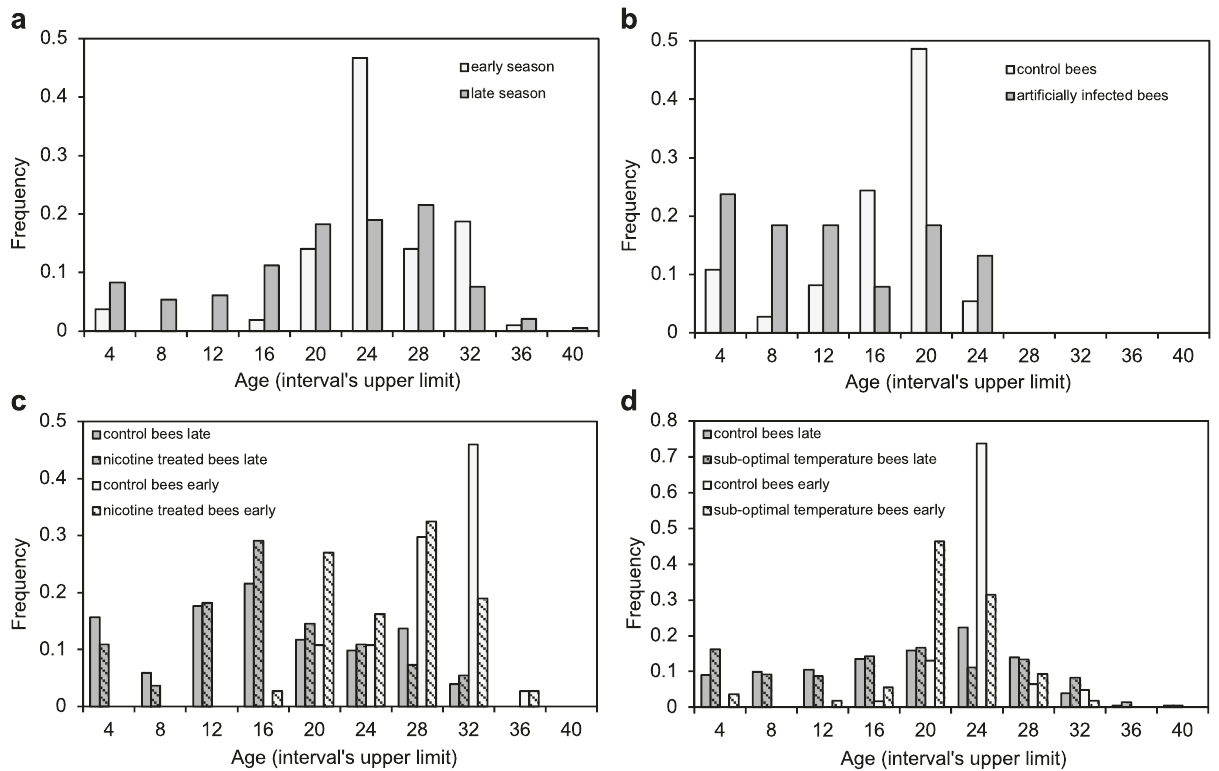
virus is widespread (gray bars with diagonal pattern); the corresponding distribu- tionofhoneybeessampledearlyorlateintheseasonandnotexposedtothetoxic compoundasacontrol(whiteandgraybars,respectively). d As( c )butexposedtoa sub-optimal temperature in place of a toxin. Source data are provided as a Source data fi